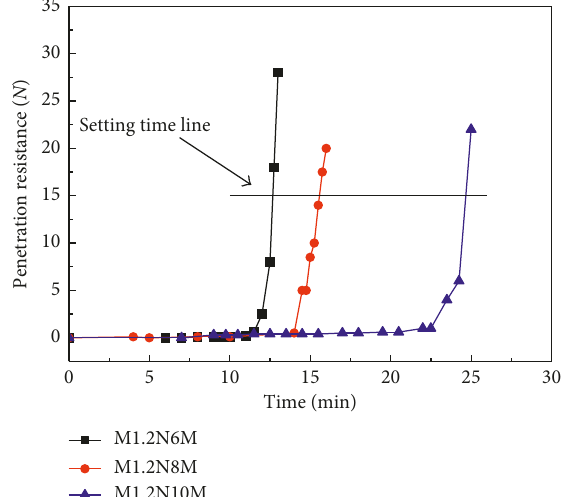
Figure 4: The effect of Na 2 O contents on the setting time of AAS mortars.